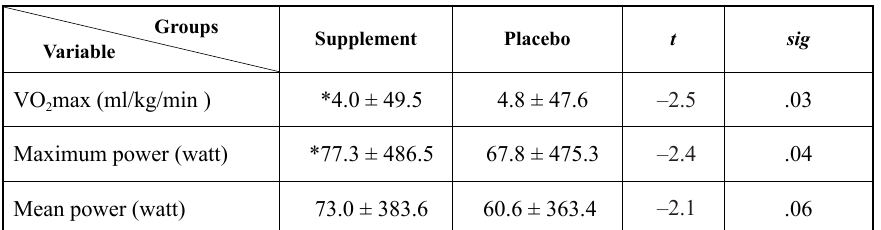
Figure. Comparison of plasma glucose and lactate in the placebo and supplementation groups after aerobic and anaerobic activity